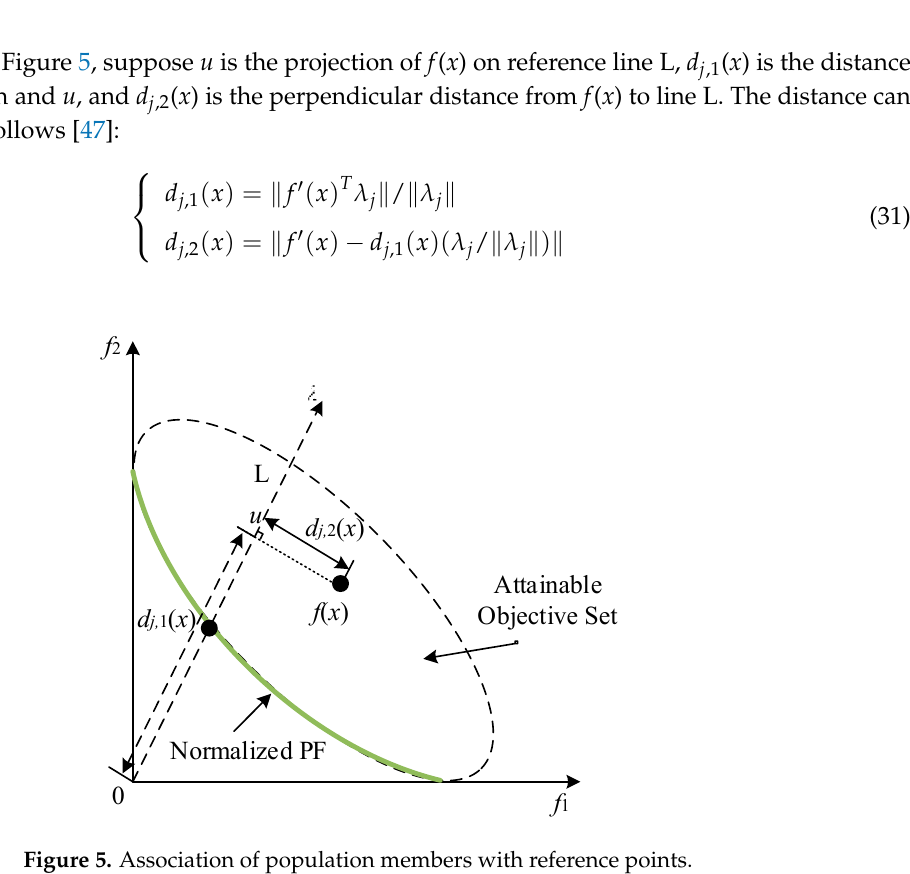
Figure 5. Association of population members with reference points.